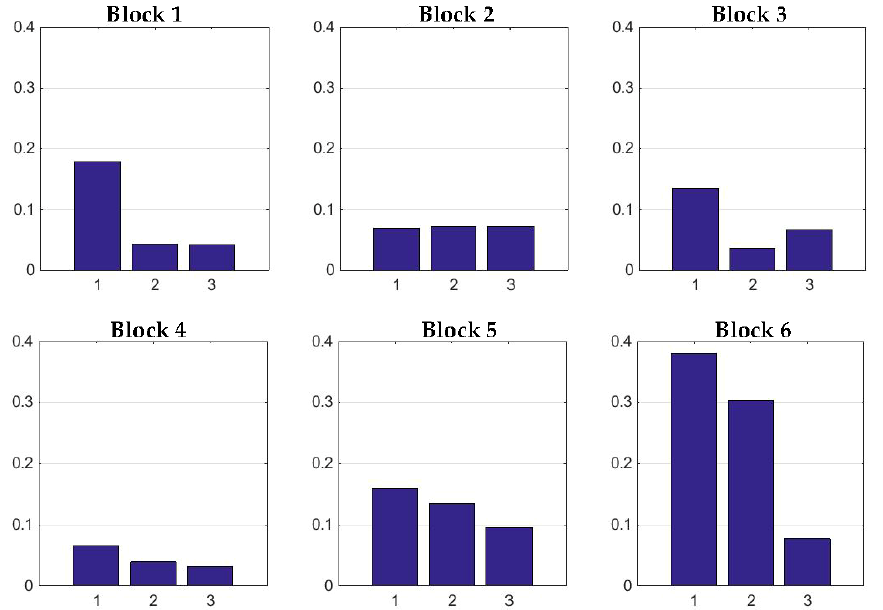
Figure 9. Results of step-by-step identification. The values of the minimized function for each block are shown: 1—without identification (J at the initial values of the control parameters); 2—after the first stage of identification; 3—after the second stage of identification.